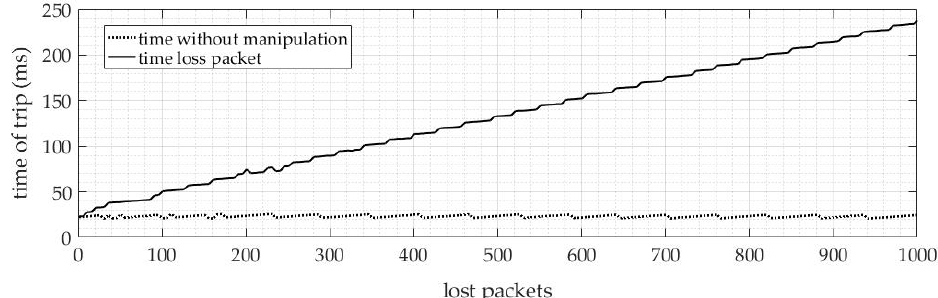
Figure 13. Tripping time results ANSI 50 — packets loss.